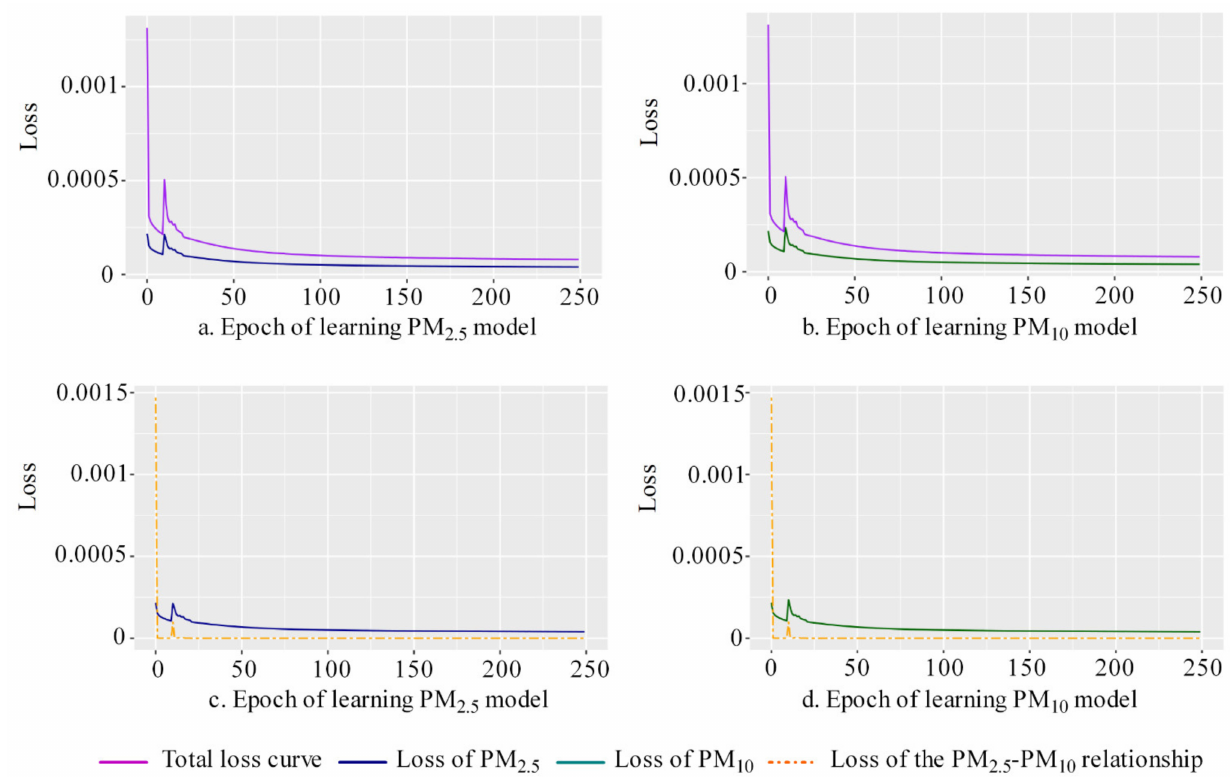
Figure 5. Curves of total loss, PM 2.5 loss ( a , c ) and PM 10 loss ( b , d ) and the loss of PM 2.5 -PM 10 relationship ( c , d ).